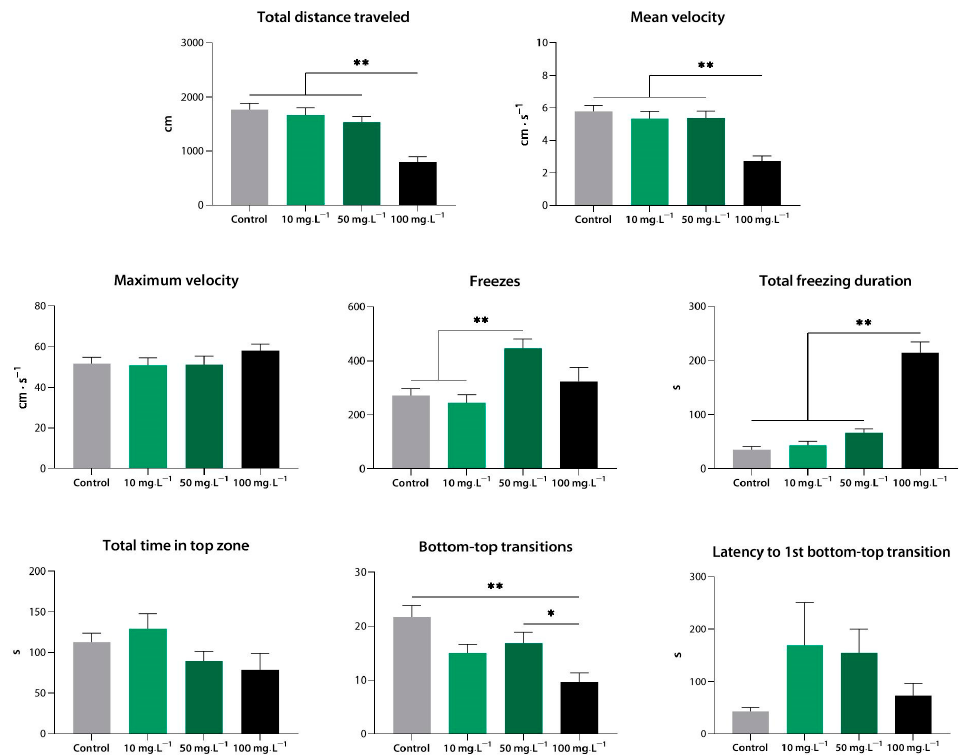
Figure 9. Quinolinic acid induces sedation in zebrafish at a range of concentrations, as assessed using the novel tank test. *, p < 0.05; **, p < 0.01.